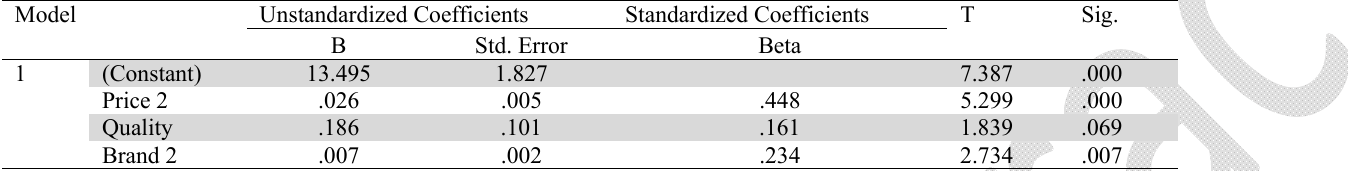
Multiple Linear Regression Test Results (Coefficients a ) Model